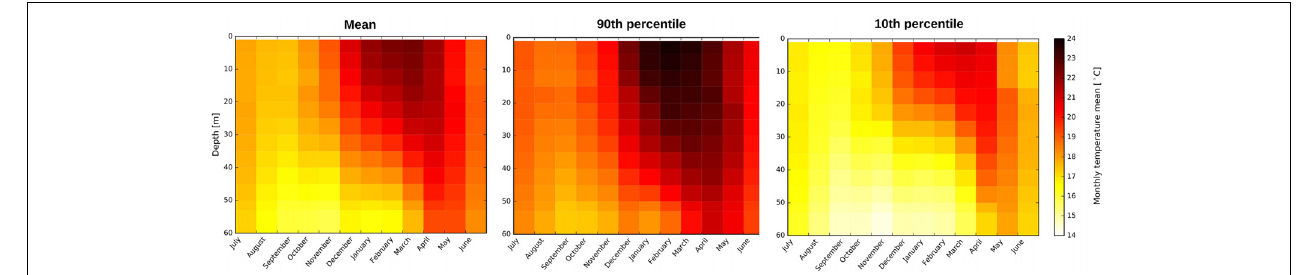
FIGURE 15 | Gridded monthly climatology for the mean, 90th and 10th percentiles of water temperature. Data are from a coastal mooring off Sydney Australia (ORS065) based on hourly observations from 1991 to